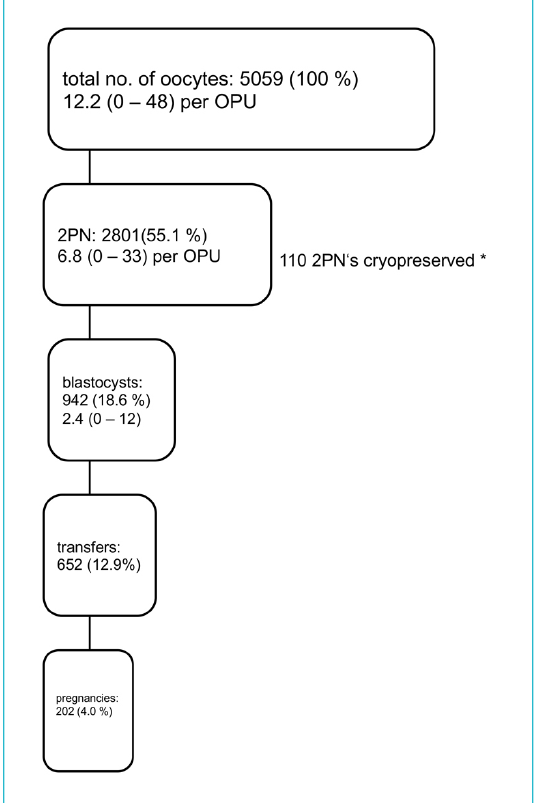
Figure 1: The stepwise fate of 5059 oocytes obtained during 413 oocyte retrievals (OPUs) in 381 infertile couples is presented graphically. IVF or ICSI led to 2801 oocytes displaying two pronu- clei (2PN, 55.1% per harvested oocyte), to 942 embryos in the blastocyst stage (55.1% per oocyte), to 652 transfers of single em- bryos (12.9% per oocyte) and to 202 pregnancies (4.0% per oocyte). * As Swiss legislation does not allow the cryostorage of more than 12 embryos, we cryopreserved 110 oocytes in the pronucleate